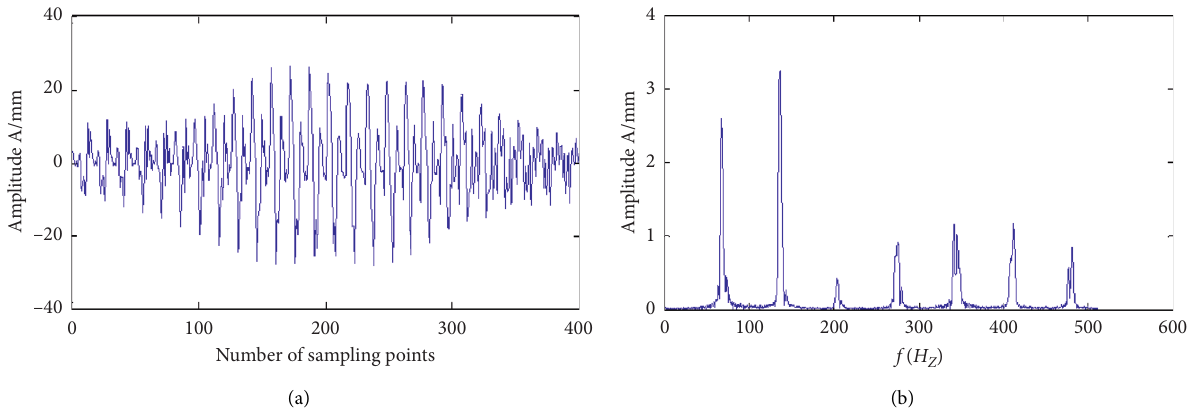
Figure 16: Processed signal. (a) Time-domain waveform of the processed signal and (b) processed signal spectrum.